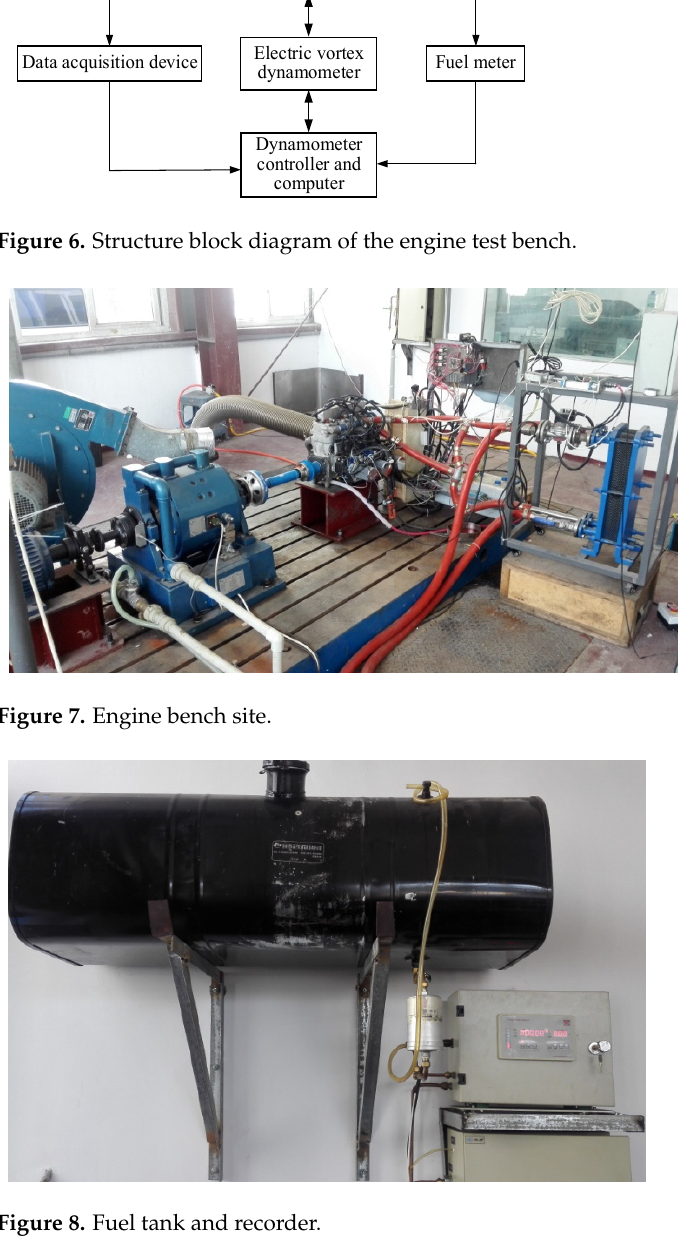
Figure 9. Tubing/oil pump/oil pressure regulation.